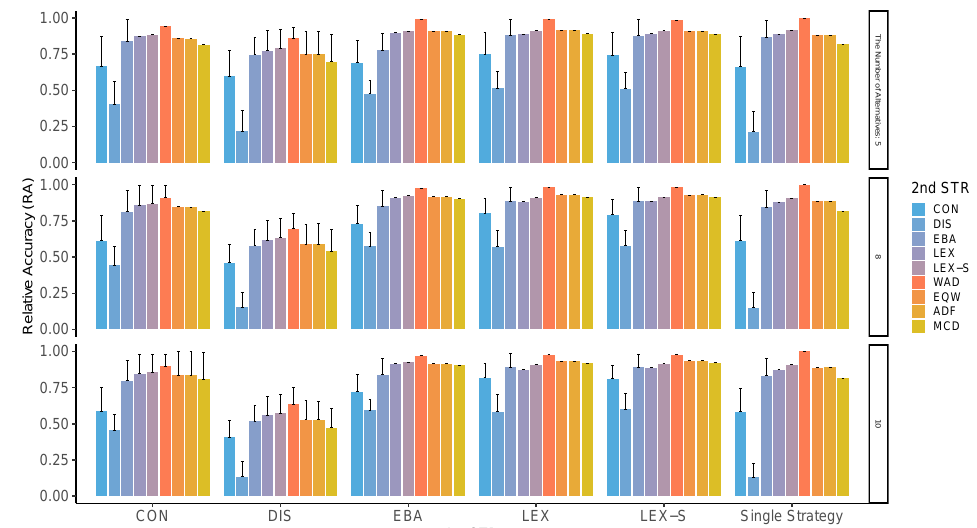
Figure A2. RA in two-stage decision-making when the number of alternatives left in the second stage is three. Note: ADF: additive difference; CON: conjunctive; DIS: disjunctive; EBA: elimination by aspects; EQW: equal-weighted strategy; LEX: lexicographic; LEX-S: lexicographic semi-order; MCD: majority of confirming dimensions; STR: strategy; WAD: weighted additive.